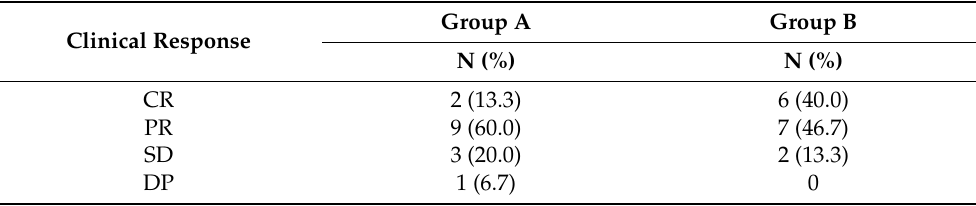
Table 2. Response to